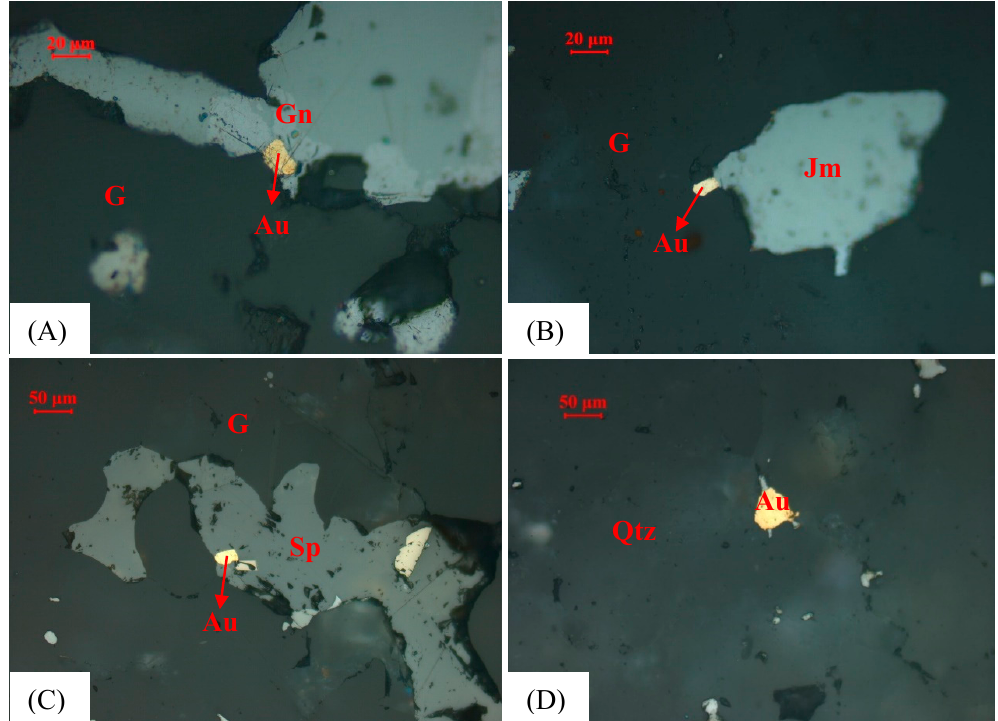
Figure 6. Images of gold in other minerals in reflected light: ( A ) gold associated with galena; ( B ) gold associated with jamesonite; ( C ) gold associated with sphalerite; ( D ) gold associated with quartz (Au—gold; Gn—galena; Jm—jamesonite; Sp—sphalerite; Qtz—quartz; G—gangue). Pyrite and Arsenopyrite